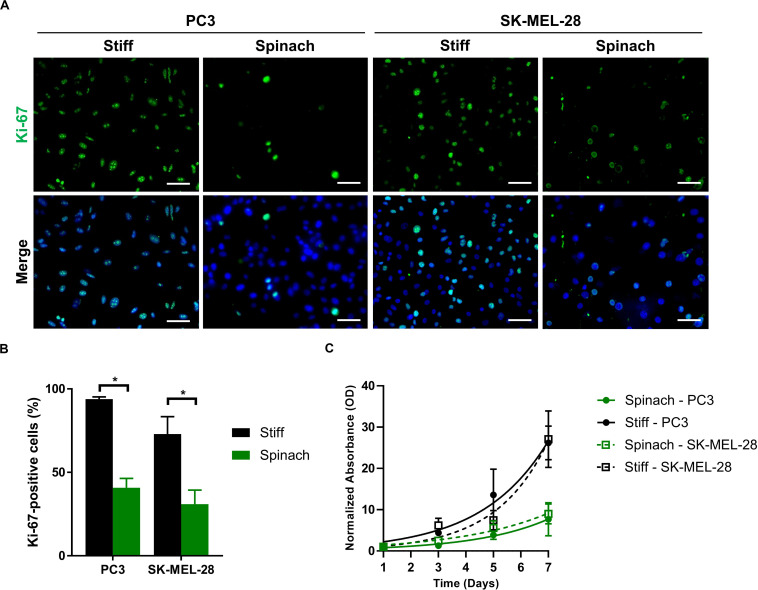
Proliferation rate was decreased for cells seeded on leaf scaffold. (A) Immunofluorescence images of Ki-67 and nuclei (DAPI) in PC3 and SK-MEL-28 cells seeded on stiff substrate (coverslip) and spinach scaffold. Scale bars = 60 μm. (B) Histogram showing the percentage of Ki-67-positive cells and represented as mean ± SEM (n = 3, *p < 0.05; Mann-Whitney test). (C) Cell proliferation of PC3 and SK-MEL-28 cells seeded for 7 days on stiff (TCPS) and spinach leaf substrate measured by modified MTT. Absorbance (570 nm) values were normalized from 100% at day 1 and analyzed using a non-linear regression using exponential growth curve. Data points represent the mean ± SEM (n = 3 with four replicates each).